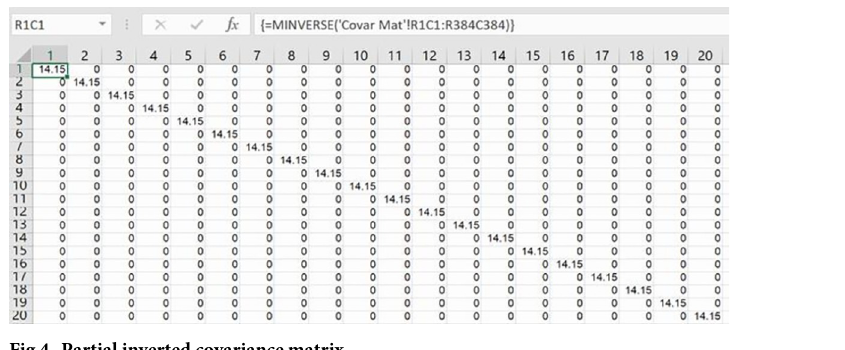
Fig 4. Partial inverted covariance matrix.